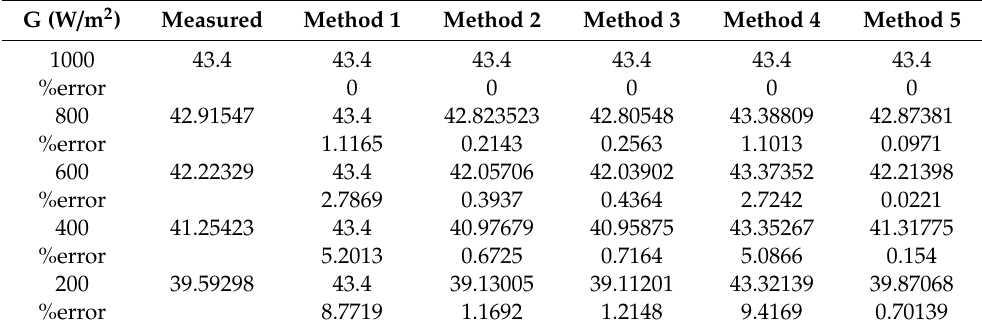
Table 6. Calculated and measured open-circuit voltage V oc (V) and relative error for the shell SQ150 module under di ff erent irradiance levels G (W / m 2 ) and temperature of 25 °C.